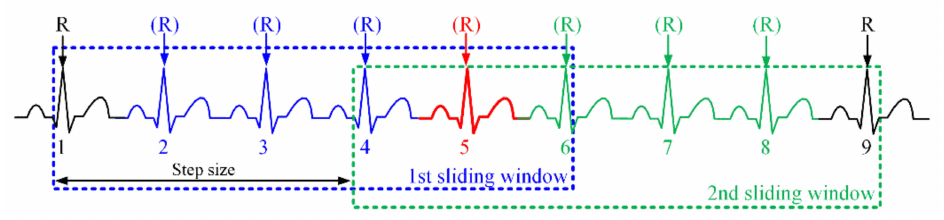
Figure 3. An example of seamless connection of successive SWs for real